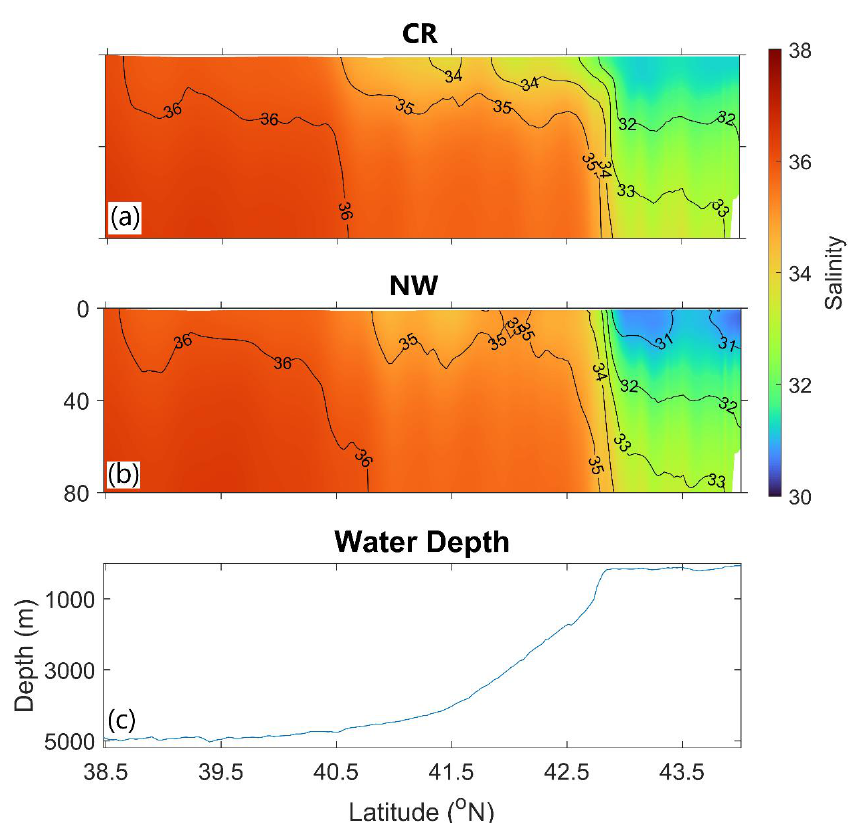
Figure 12. Vertical distributions of monthly-mean salinity for August 2018 in the top 80 m simulated by submodel L2 in cases ( a ) CR and ( b ) NW along cross-shelf transect PQ (shown in Figure 1b), and ( c ) profile of local water depths along transect PQ.